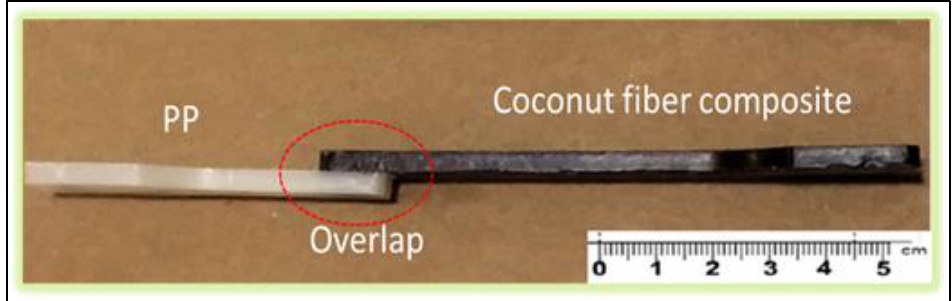
Figure 3. Demonstration of the overlap between the materials.